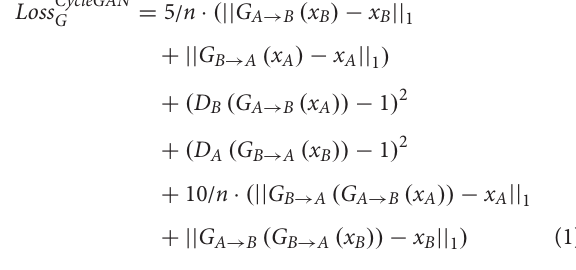
high-fidelity images and in generating stylized task-oriented training samples without additional manual annotation and device